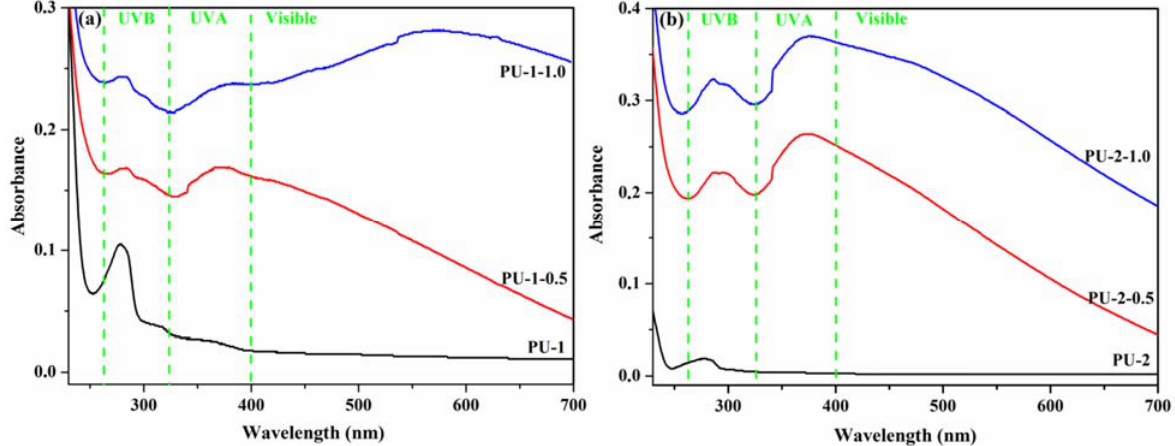
Figure 9. UV–VIS absorption spectra of the polyurethane nanocomposite films: PU-1, PU-1-0.5 and PU-1-1.0 ( a ) and PU-2, PU-2-0.5 and PU-2-1.0 ( b ).